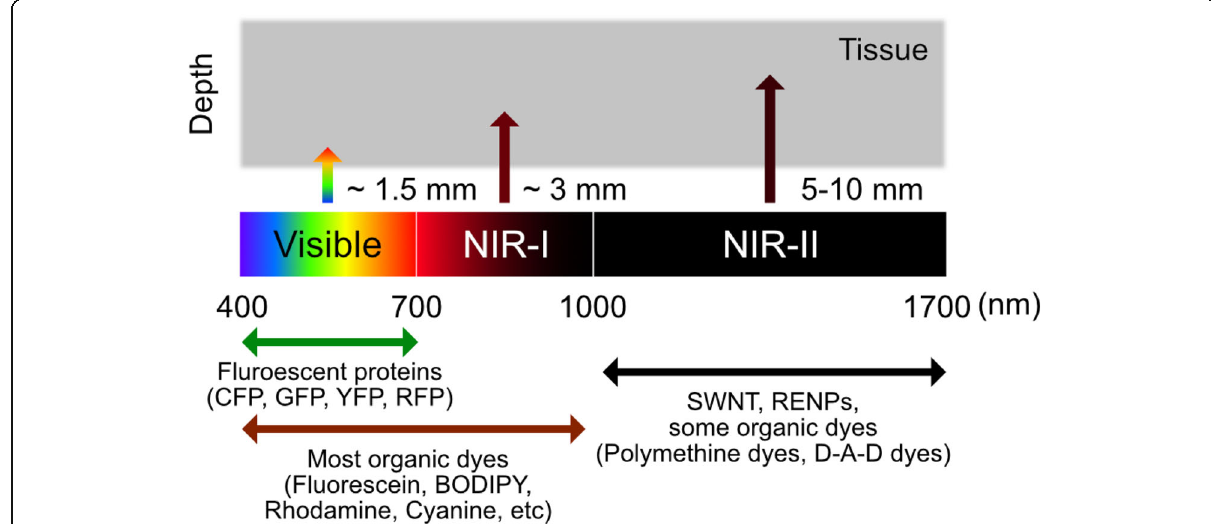
Fig. 5 Commonly used materials for fluorescence imaging. Diagrams of the spectral ranges of the major fluorescence materials and its tissue penetration capacity. SWNTs, single walled carbon nanotubes; RENPs, rare-earth doped nanoparticles; D-A-D,